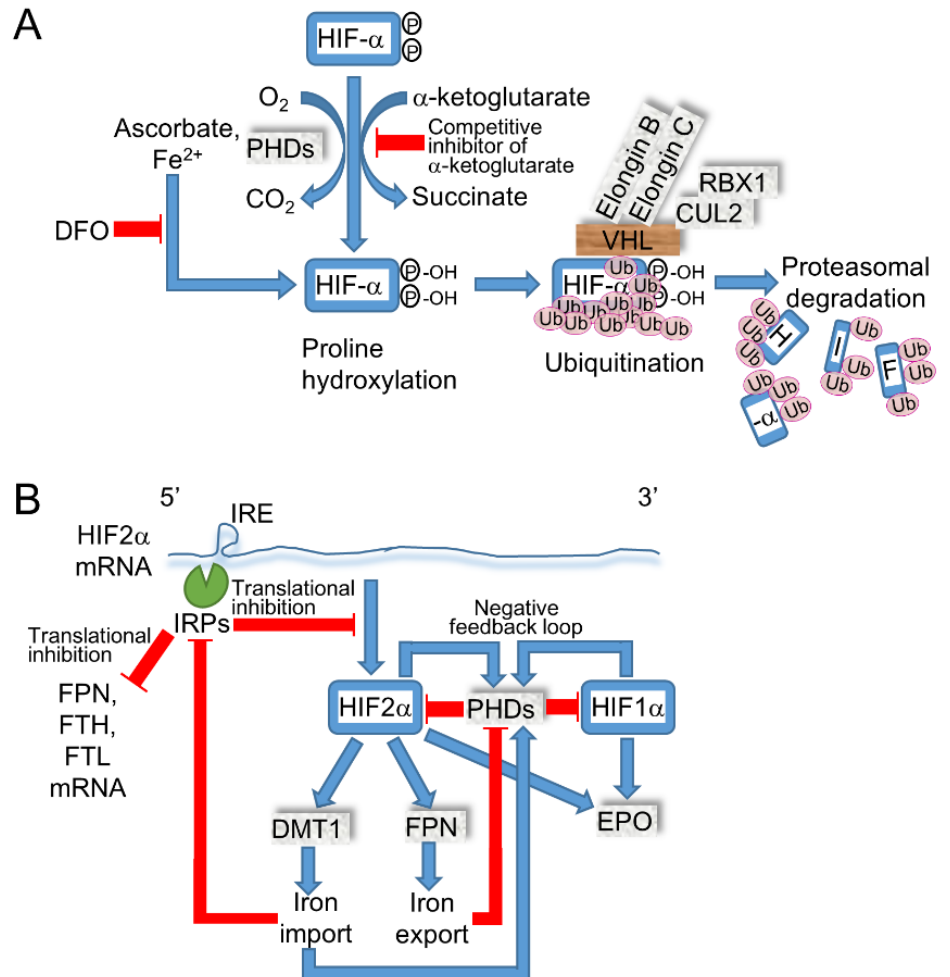
Figure 3. Iron-regulated HIF- α expression. ( A ) HIF- α is hydroxylated by PHDs, which are suppressed by molecular oxygen depletion or iron chelation. The hydroxylations at the proline in HIF- α induce recognition by the VHL complex, which initiates ubiquitination-dependent proteasomal degradation. Competitive inhibitors of α -ketoglutarate are prescribed for renal anemia to inhibit PHDs, and, in turn, stabilize HIF- α [75]. ( B ) HIF2 α , which is translationally suppressed by IRE/IRPs as FPN (ferroportin), FTH (ferritin heavy chain), and FTL (ferritin light chain), transcribes DMT1 and FPN [74]. The increased cytoplasmic iron may activate PHDs, while IRE/IRP-dependent translational inhibition is decreased.